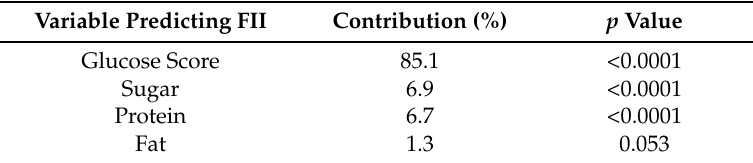
Table 1. Percentage contribution and significance level for each variable selected in a stepwise multiple linear regression analysis to predict the Food Insulin Index (FII) in Equation